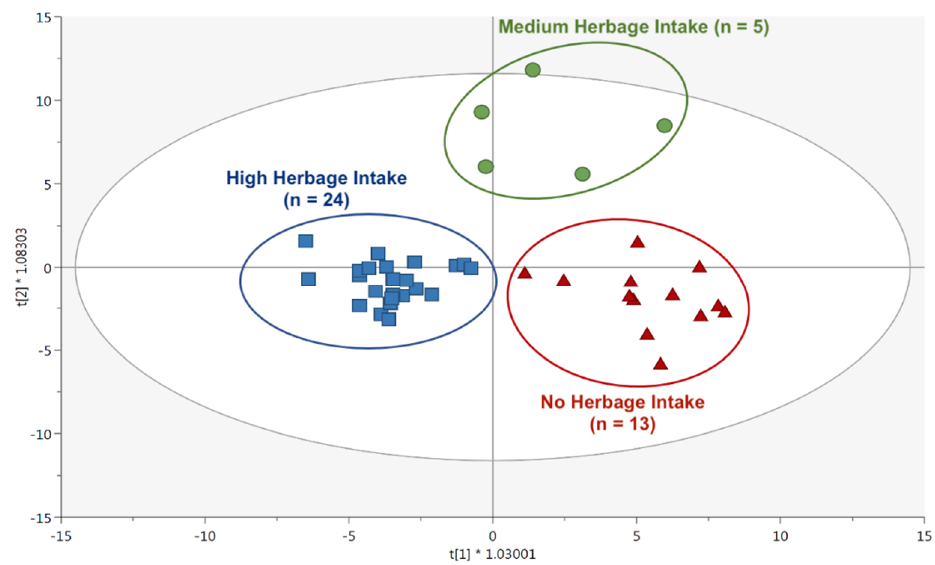
Figure 2. OPLS-DA score plot on the metabolomics profile of Sarda sheep milk considering the different fresh herbage intake levels as discriminant parameter.